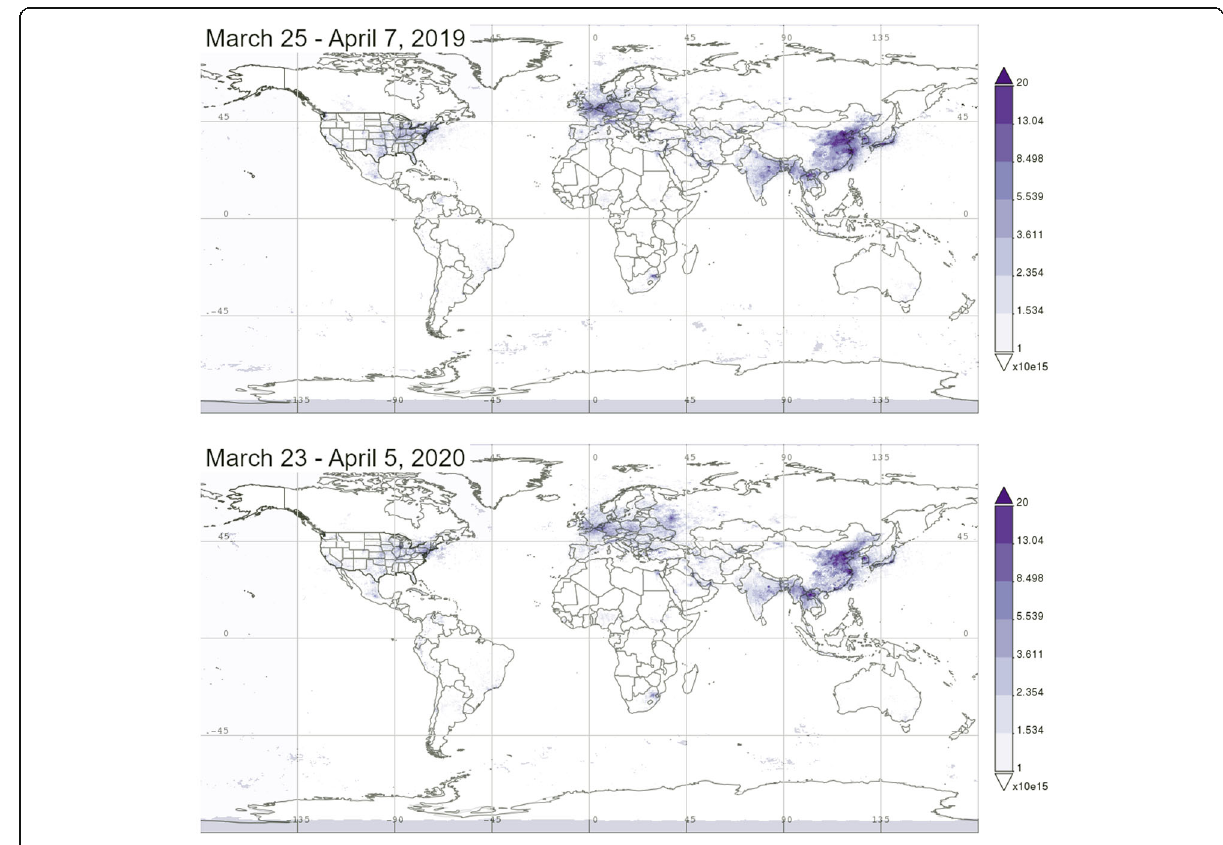
Fig. 1 NO 2 (nitrogen dioxide) in the tropospheric column (mol cm − 2 ) for the first 14 days of spring 2019 (top) and 2020 (bottom), respectively, several weeks after many countries worldwide initiated lockdowns [maps generated with the Giovanni online tool (Prados et al. 2010) using data from the Ozone Monitoring Instrument on NASA ’ s Aura satellite, 30% cloud screened, daily 0.25°